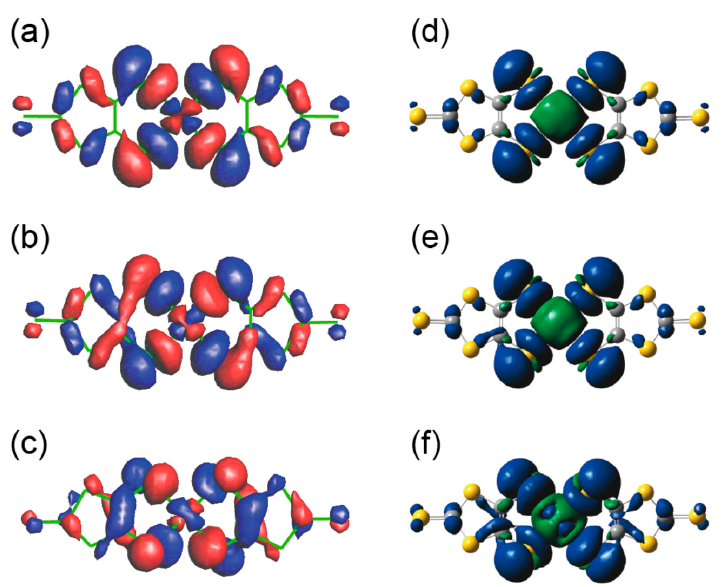
Figure 4. Calculated singly-occupied molecular orbitals (SOMO) (( a ) 1 ; ( b ) 2 ; and ( c ) 3 ) via extended Hückel calculation and spin densities (( d ) 1 ; ( e ) 2 ; and ( f ) 3 ) for [Cu(dmit) 2 ] 2 − anions via Gaussian 09 (B3LYP/6-31+G(3d)). Red and blue in ( a )–( c ) and green and blue in ( d )–( f ) designate different orbital lobes. Green lines in ( a )–( c ) and grey lines in ( d )–( f ) designate chemical bonds. In ( d )–( f ) yellow and grey spheres designate S and C atoms, respectively. For each molecular structure, see Figure 2. MOs of excited states are shown in Figure S9 in the Supplementary Materials.